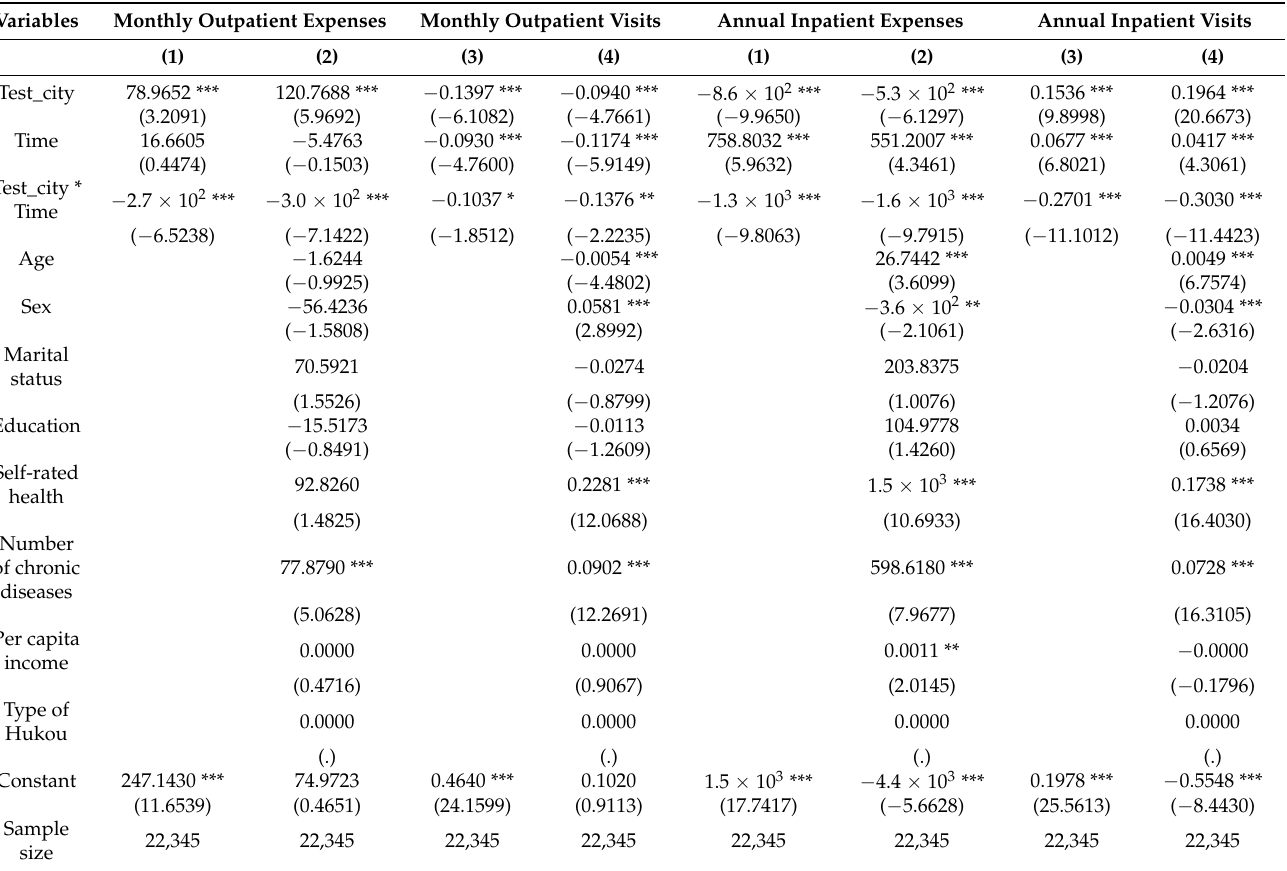
Table 5. PSM-DID results of rural areas.